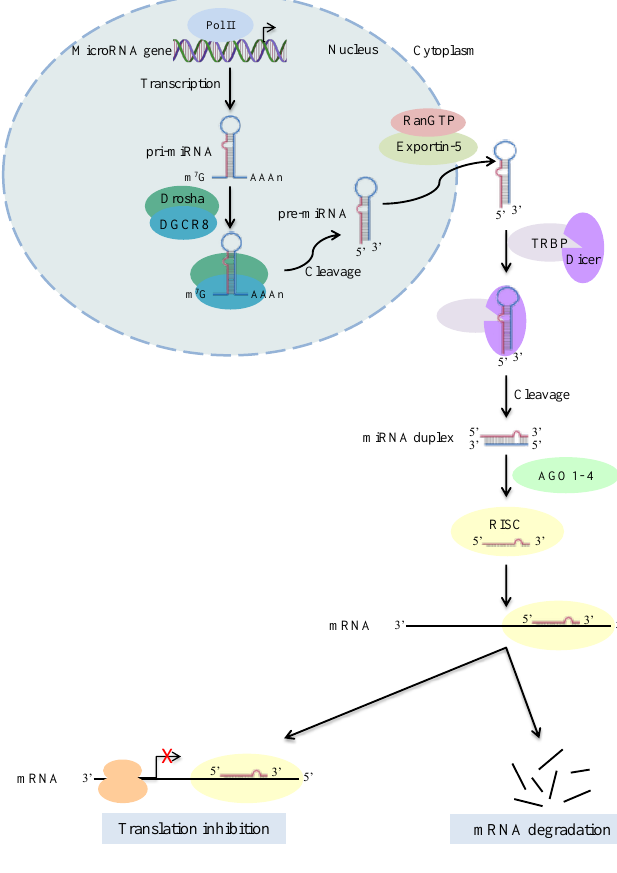
Figure 1. The canonical pathway of microRNA (miRNA) biogenesis. After the transcription of a miRNA gene by RNA polymerase II, the produced primary miRNA (pri-miRNA) is cleaved by the microprocessor complex Drosha-DGCR8, generating the precursor miRNA (pre-miRNA). Following the export of pre-miRNA from the nucleus by Exportin-5-RanGTP, the Dicer ribonuclease, in complex with TRBP (TAR-binding protein), cleaves the pre-miRNA hairpins to generate the mature miRNA, a small non-coding RNA (nc-RNA) of ~22 nucleotides in length. The functional strand of the mature miRNA is loaded together with Argonaute proteins (AGOs) onto the RNA-induced silencing complex (RISC) and it can then direct post-transcriptional repression via mRNA complementarity. Downregulation of gene expression can occur through translational repression with or without mRNA cleavage, depending on whether the miRNA has full or partial complementarity to the target mRNA,